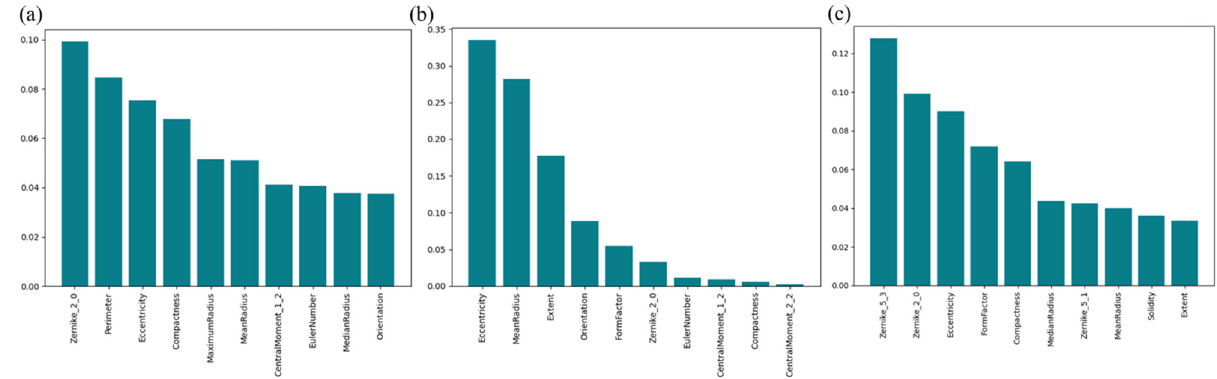
Figure 10: Feature importance rank to predict hardness of CNTs/AlSi10Mg nanocomposites for di ff erent ML methods: ( a ) AdaBoost, ( b ) decision tree, and ( c ) Extra